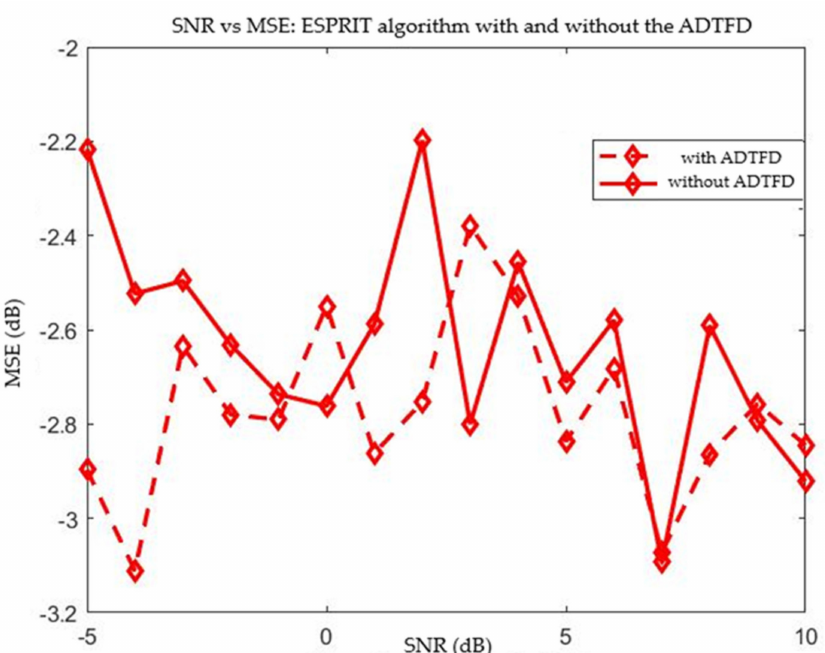
Figure 8. SNR vs. MSE plot of the ESPRIT algorithm with and without ADTFD (solid line and the dashed line represents the cases without ADTFT and with ADTFD, respectively).